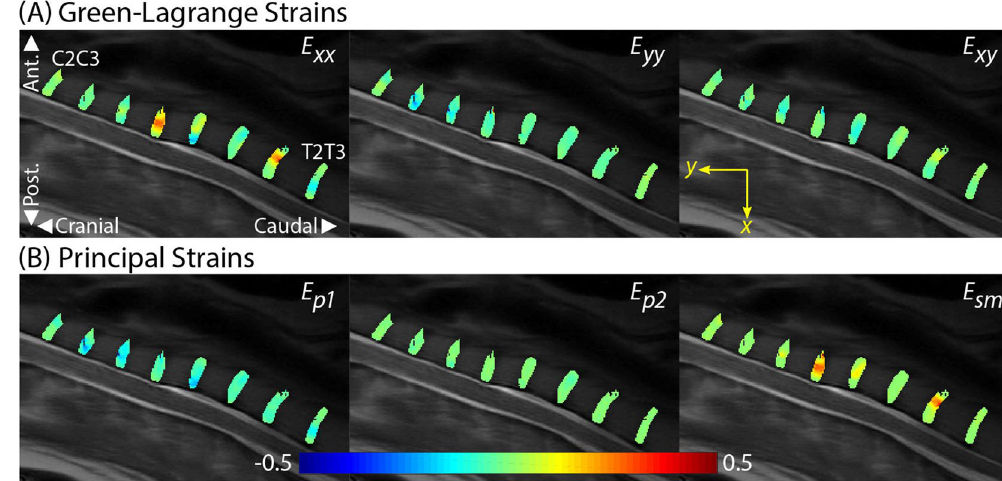
Figure 3. dualMRI facilitates the calculation of spatially complex Cartesian-based and principal direction strains on adjacent IVDs (C2C3–T2T3). ( A ) Green–Lagrange strains ( E xx , E yy , E xy ) were calculated at each voxel location from the smoothed displacement fields. Strains of increased magnitude were observed in the E xx data. ( B ) Principal strains ( E p1 , E p2 ) and maximum shear strain ( E sm ) indicated spatial heterogeneity of magnitudes and demonstrated prominent patterns of elevated E p1 and E sm